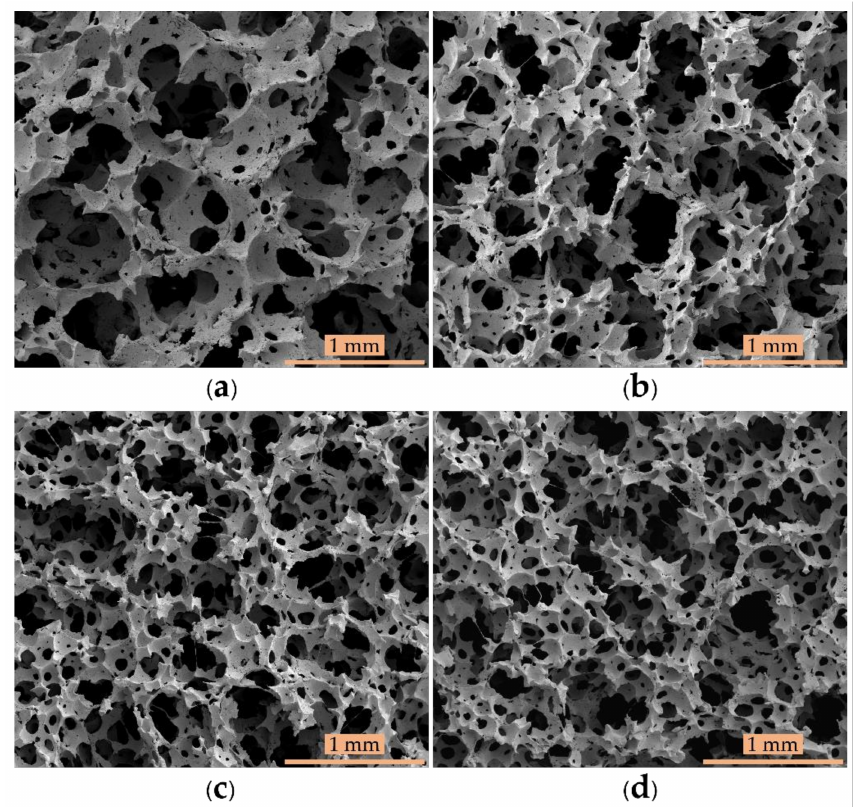
Figure 1. SEM images of foams created with various concentrations of chemical blowing agent at 150 × magnification: ( a ) control foam, ( b ) control - 15% Po foam, ( c ) control - 30% Po foam, and ( d ) control - 45% Po foam.